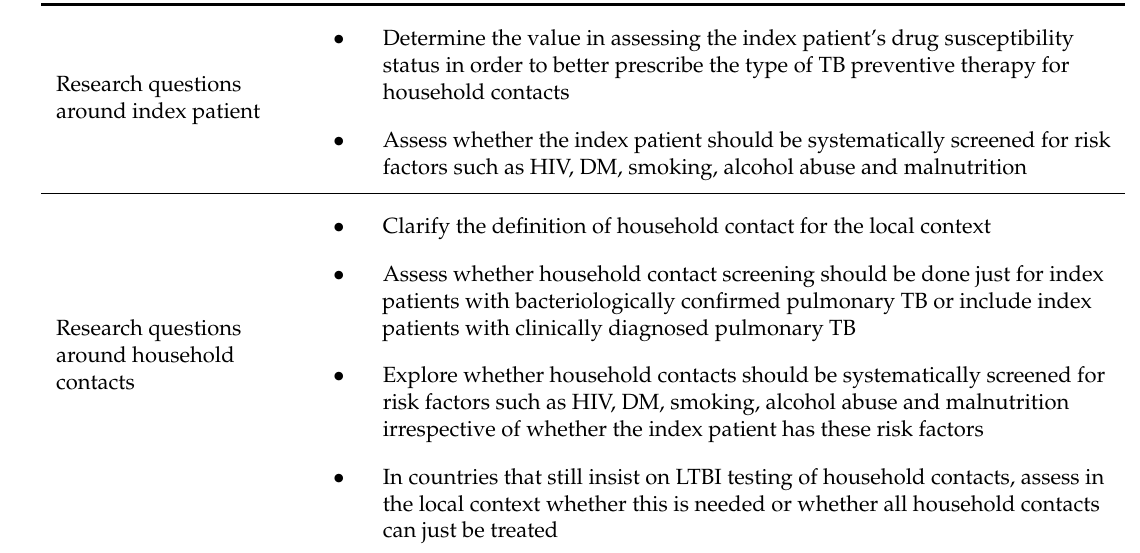
Table 5. Research and innovation on the index patient and their household